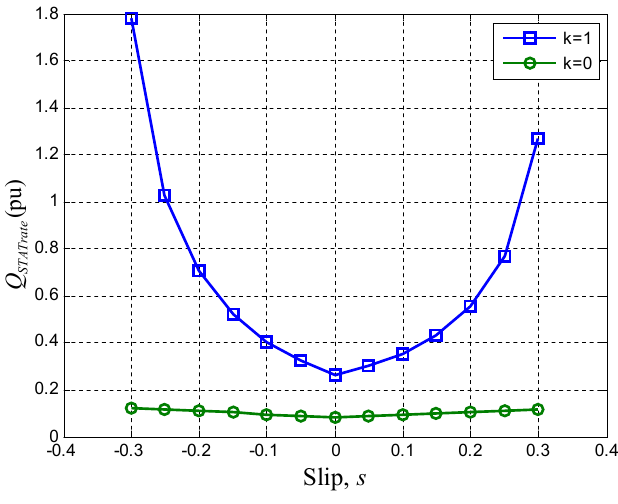
Figure 9. Capacity matching of STATCOM through DFIG’s operative slip range.